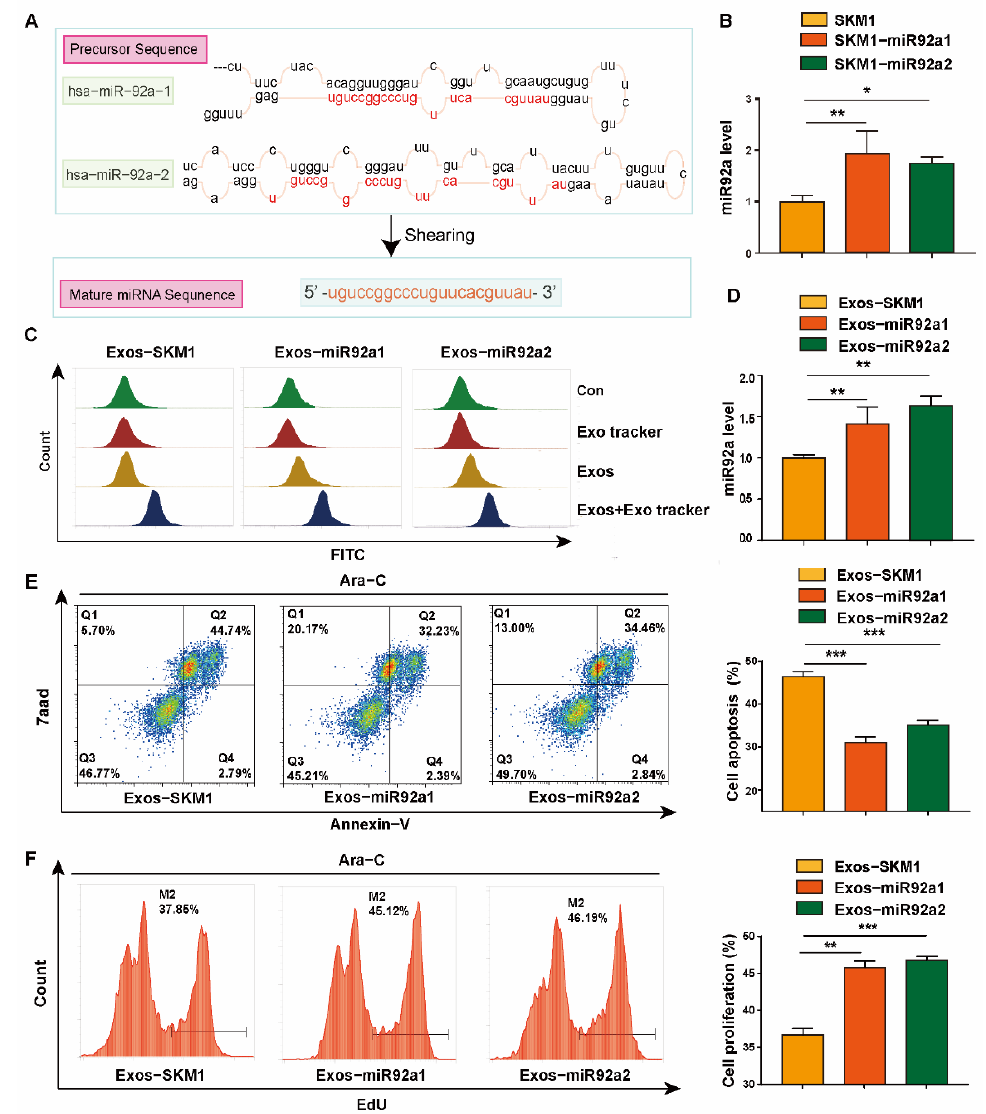
Figure 2. Exosomal miR92a increased resistance to Ara-C of recipient cells. ( A ) Two precursors of miR92a. ( B ) miR92a level in SKM1 and SKM1-miR92a1/2 cells. ( C ) Uptake of Exos-SKM1 and Exos-miR92a1/2 in SKM1 analyzed by flow cytometry. ( D ) miR92a level in SKM1 treated with Exos-SKM1, Exos-miR92a1/2 for 48 h. ( E , F ) Apoptosis ( E ) and proliferation ( F ) of SKM1 treated by 2 µ M Ara-C and 10 µ g Exos-SKM1 or Exos-miR92a1/2 for 48 h analyzed by flow cytometry. * p < 0.05, ** p < 0.01, *** p < 0.001.